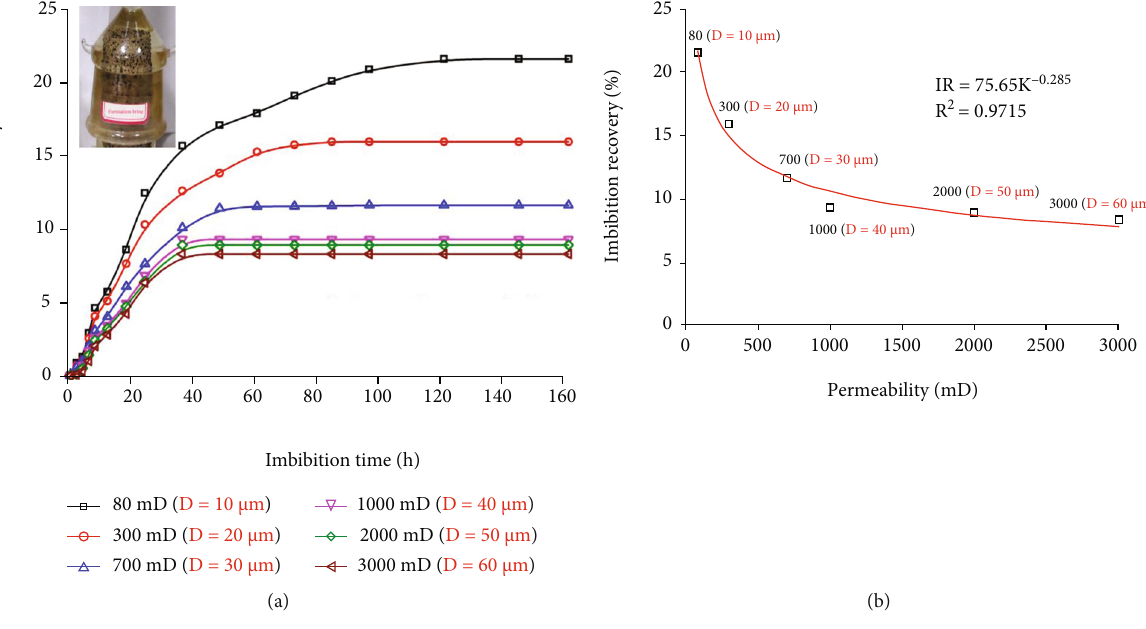
Figure 5: (a) Results of imbibition time versus with imbibition recovery in six di ff erent permeabilities cores. (b) Relationship between core permeability and imbibition